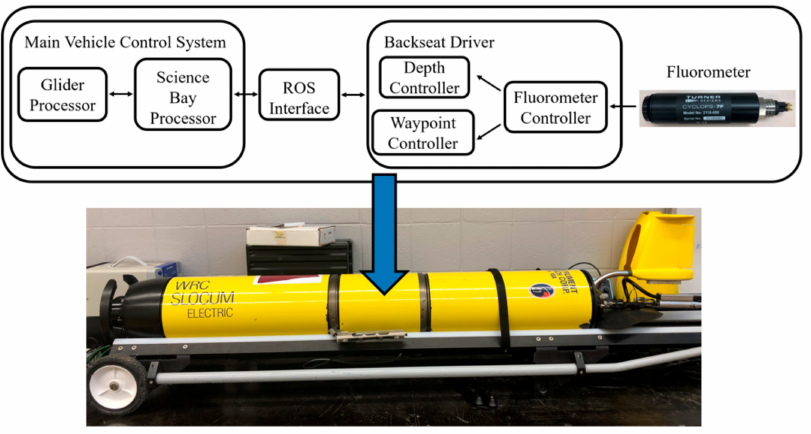
Figure 3. Backseat control architecture of Slocum glider with a fluorometer supporting the control of depth and